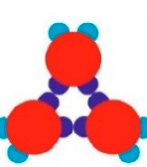
Figure 3. A stable trimer of model PPs: three monomers, mutually oriented at 120 degrees, connected by three SN-SN patch bonds.